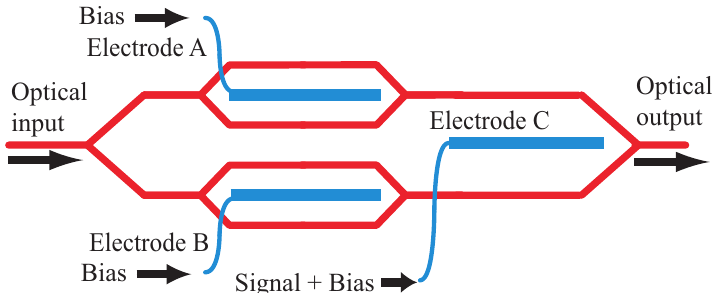
Figure 2. Integrated MZM with two active trimmers.